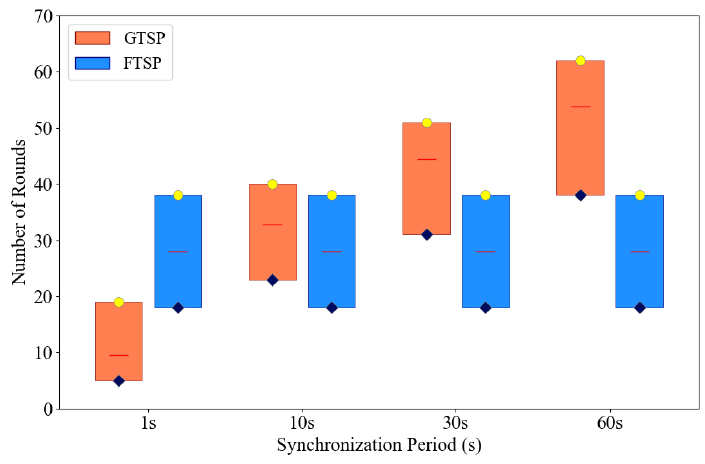
Figure 7. Number of rounds required to synchronize entire network in FTSP and GTSP with different synchronization